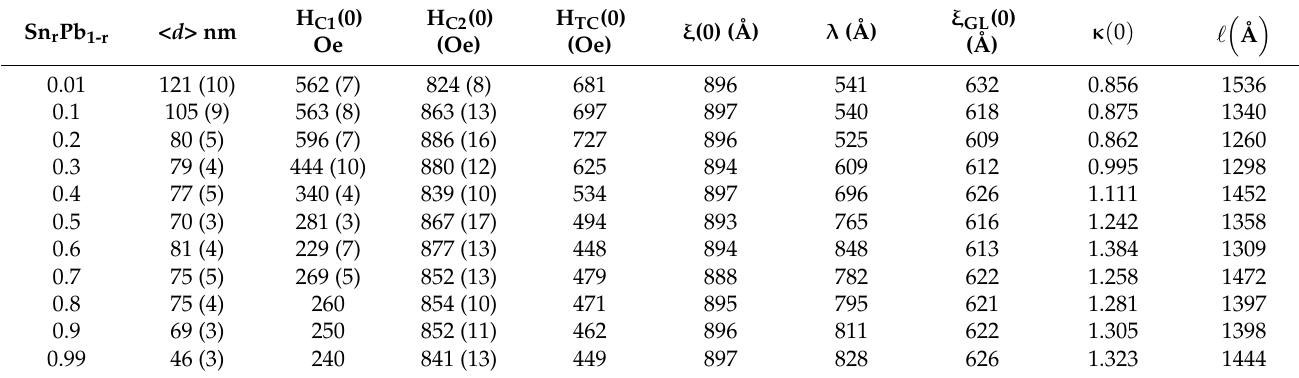
Table 2. Summary of obtained physical parameters: mean granular size < d >, critical field H C1 (0), upper critical field H C2 (0), and thermodynamical critical field H C (0), Ginzburg–Landau coherence length ξ GL (0), Ginzburg–Landau parameter k, penetration depth λ (0), and mean free path (cid:96) of Sn r Pb 1-r nanoalloys estimated within the superconducting